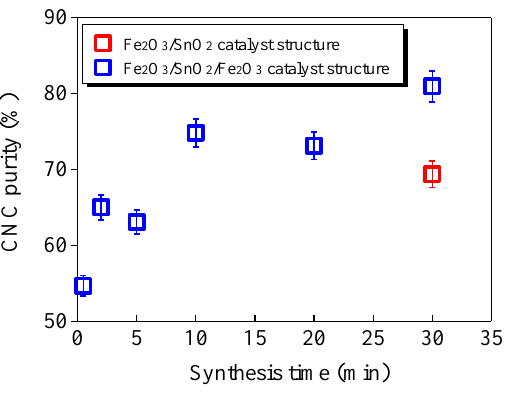
Figure 7. CNC purity vs. synthesis time at spin-coating velocity of 1000